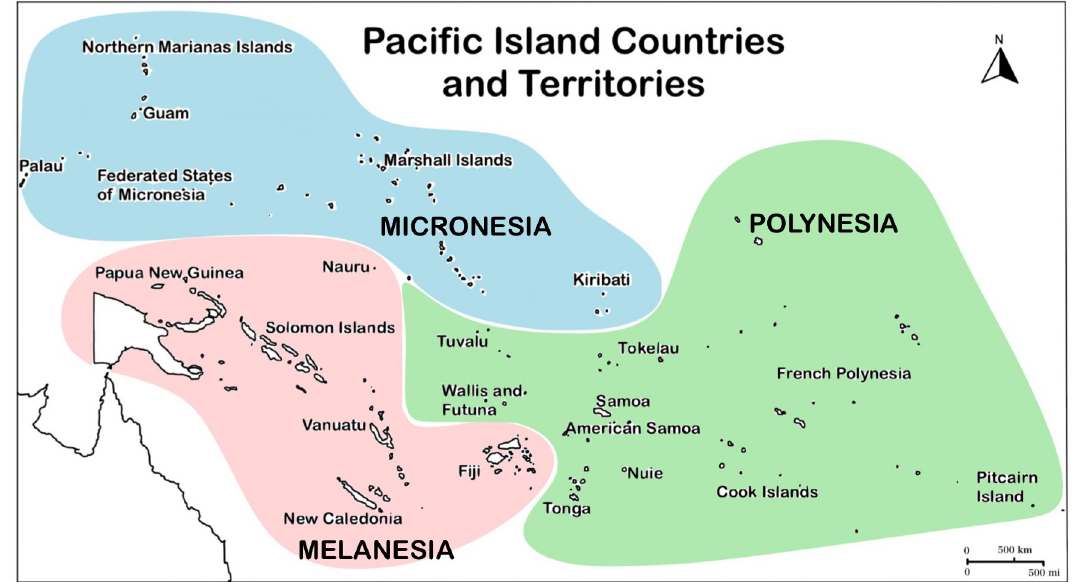
Fig 1. Pacific Island Countries and Territories (PICTs) of the Western Pacific Region. PICTs are grouped by Micronesian, Melanesian, and Polynesian ethnicities. The base layer image from which the figure was initially drawn can be found at